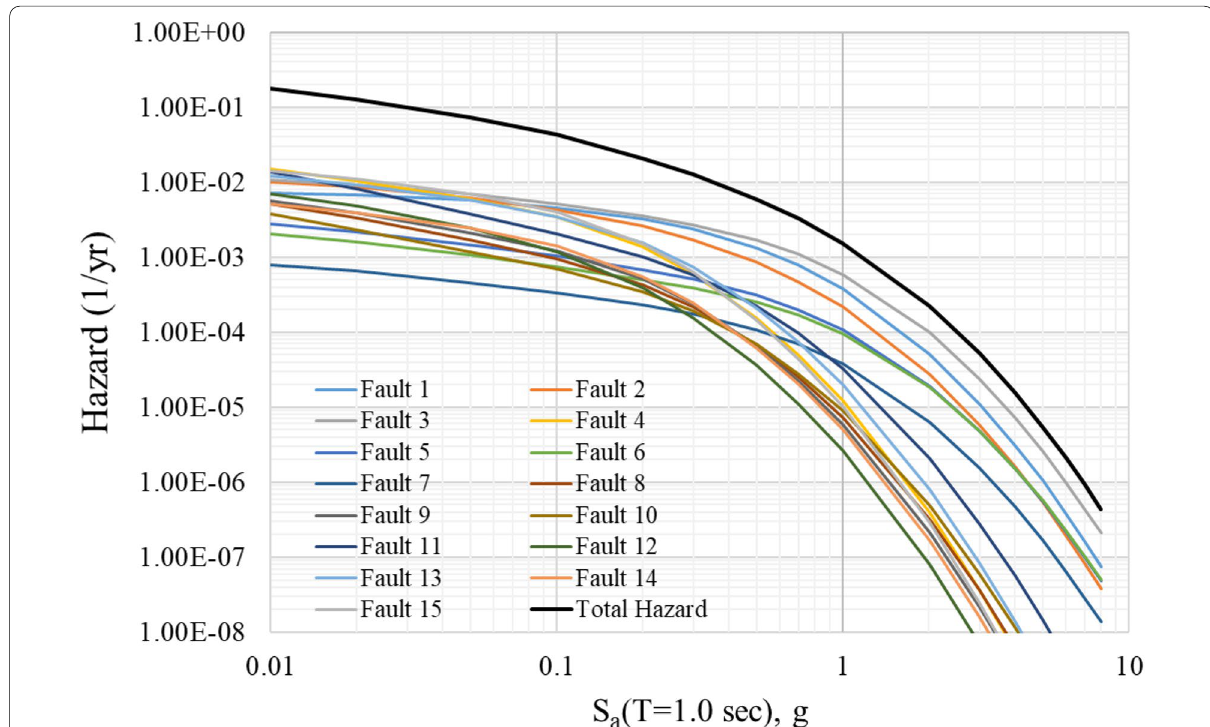
Fig. 7 Hazard curves for various fault segments and total hazard at site at target spectral